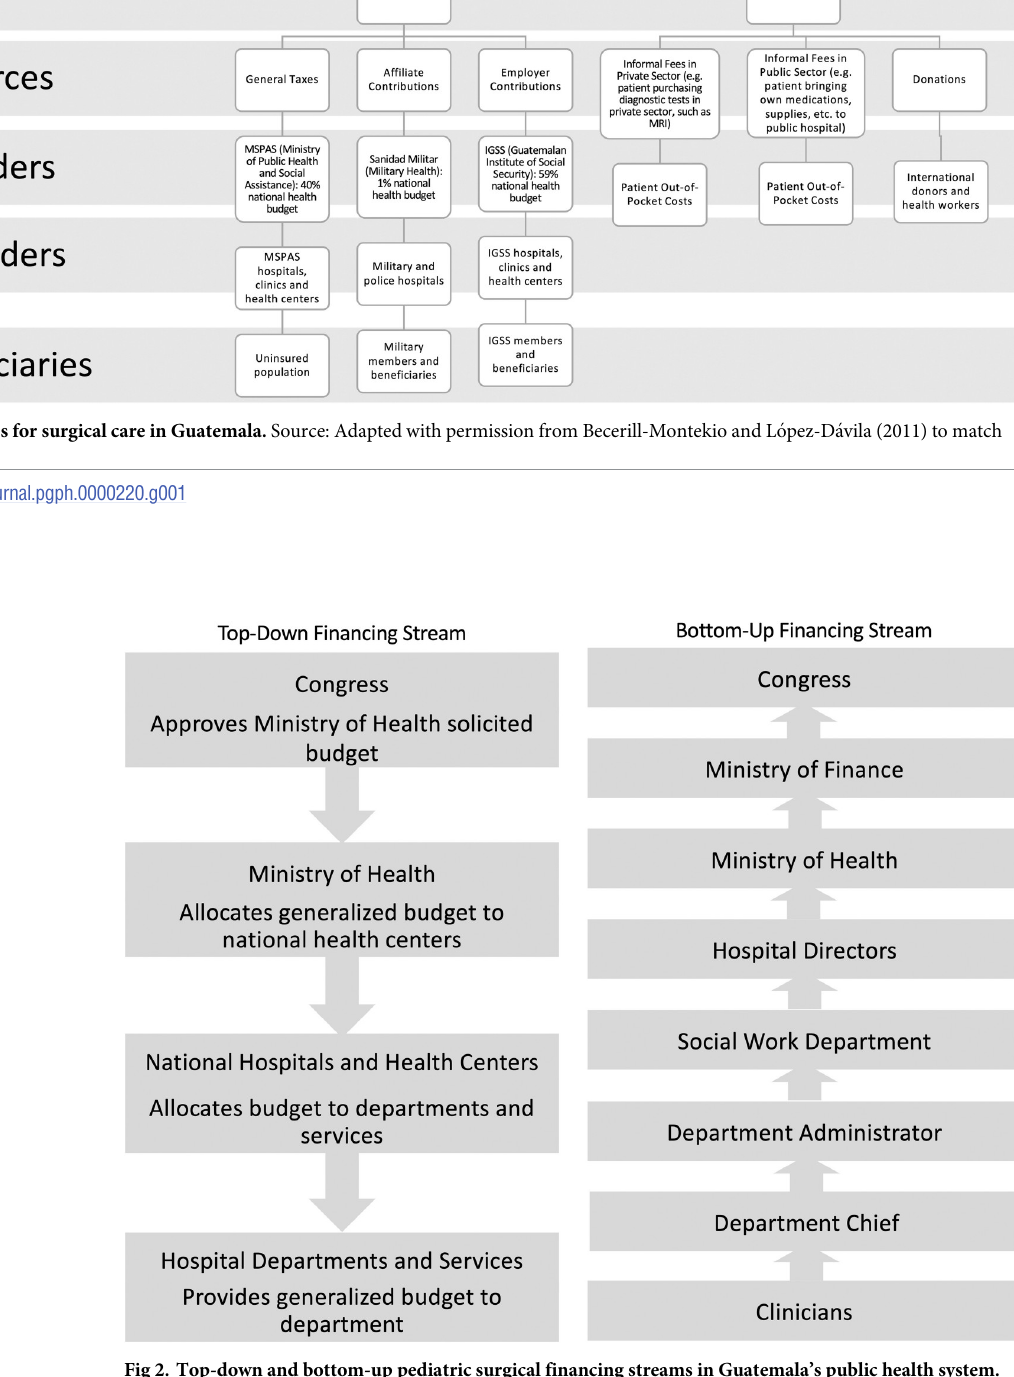
PLOS Global PublicHealth | https://doi.org/10.1371/journal.pgph.0000220 September 21, 2022 5 /